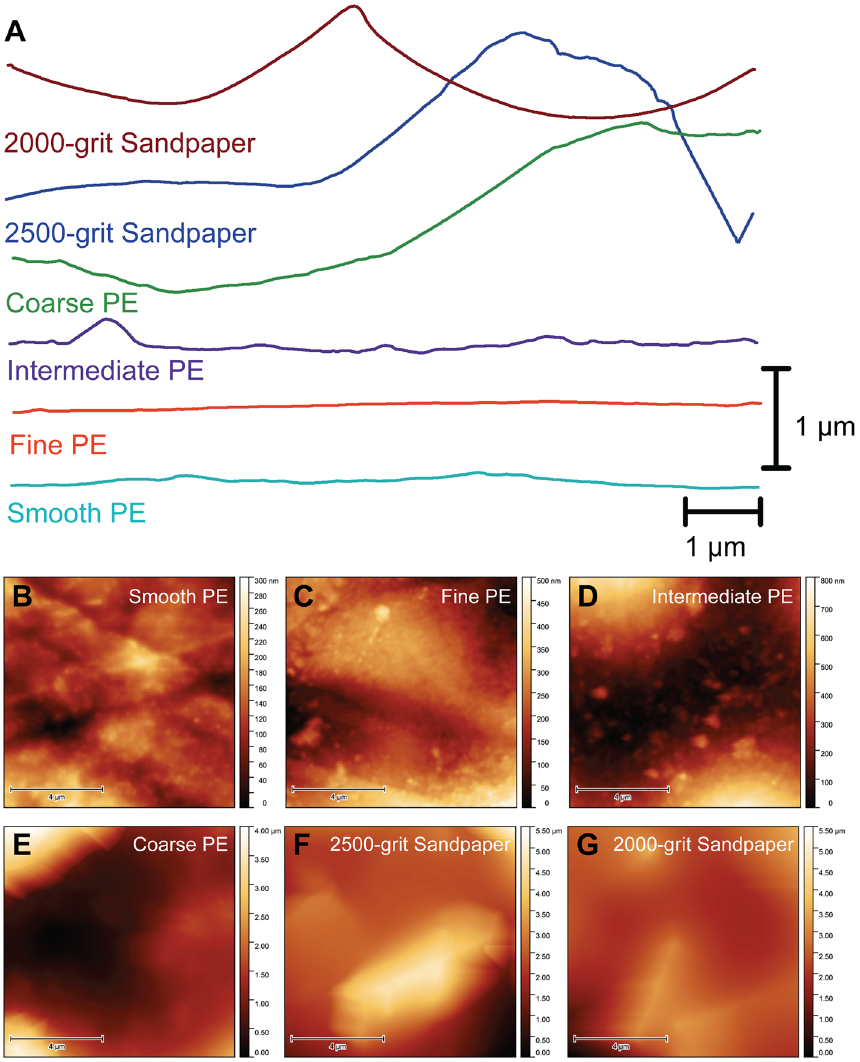
Figure 1. ( A ) Representative line scans of each substrate used in this experiment. Line scans of 10 μm in length were obtained along the x-axis of the representative 10 µm × 10 µm atomic force microscopy (AFM) scans shown in ( B – G ). Horizontal line scans were centred on the y-axis. ( B – G ) Representative 10 µm × 10 µm AFM scans of the substrates used in this experiment. PE =